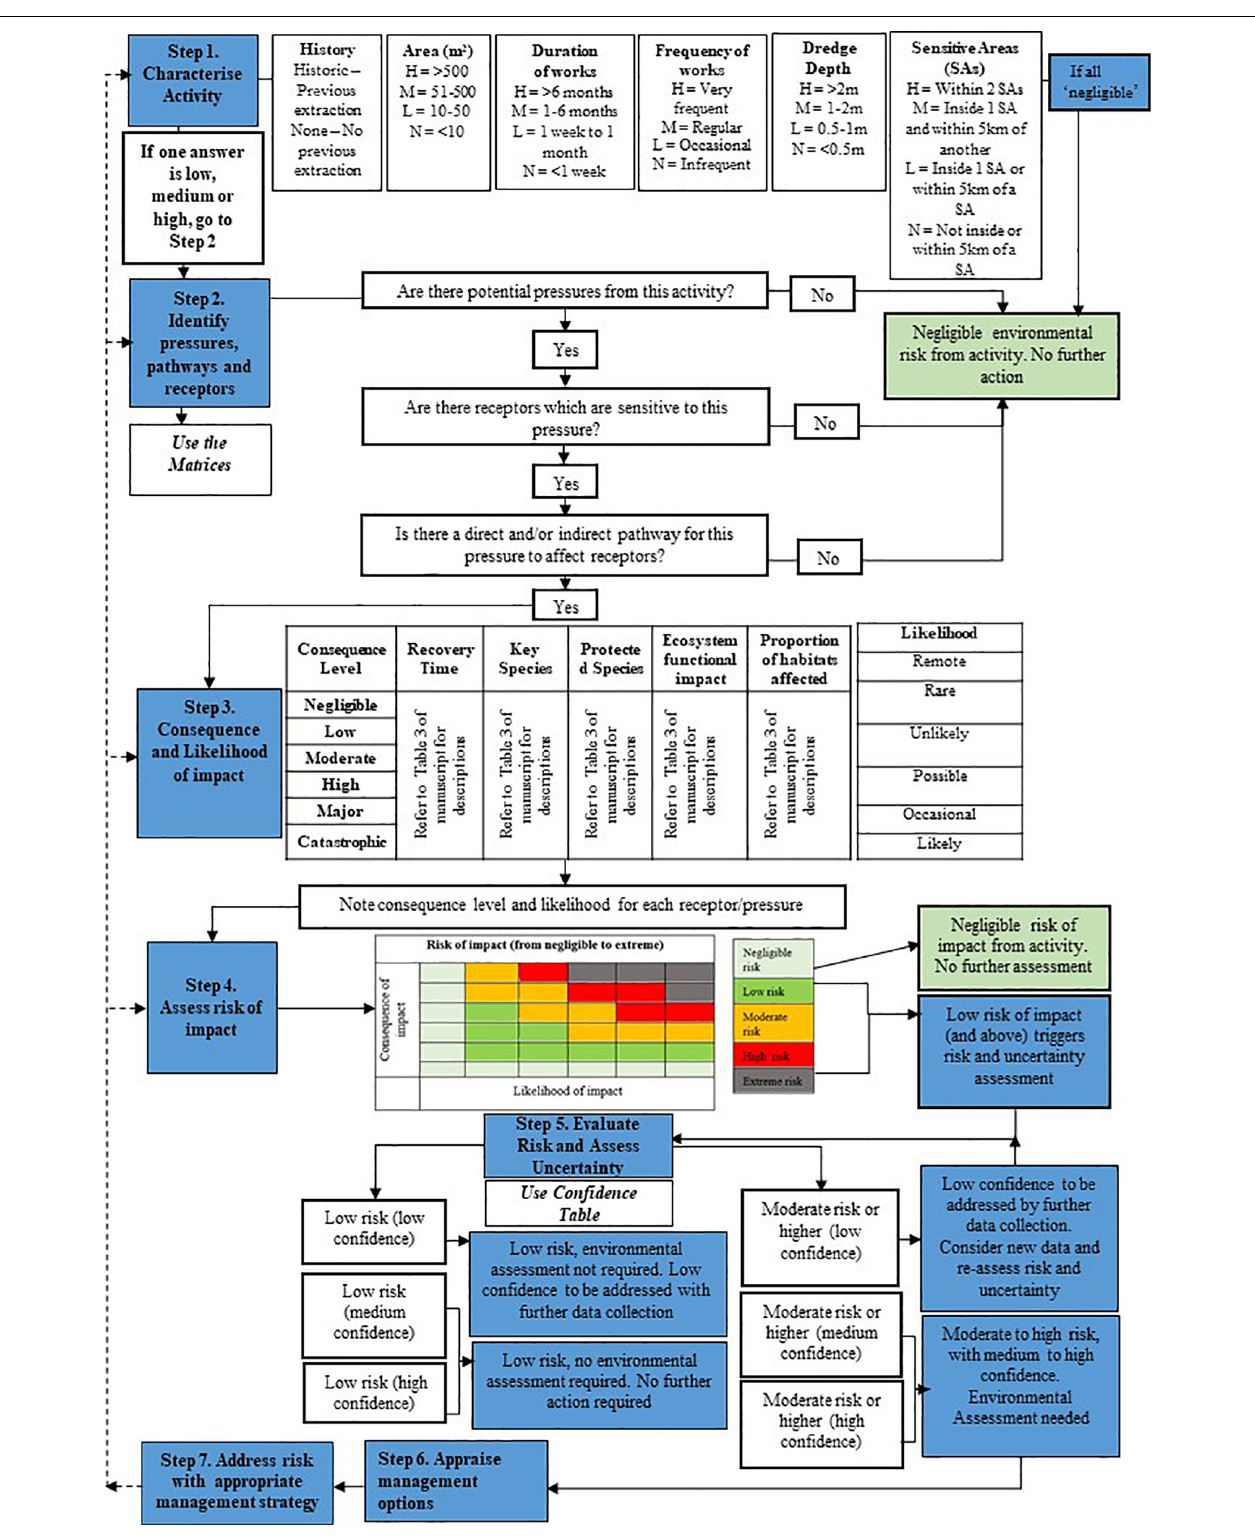
FIGURE 1 | Decision tree for assessing potential risks posed by sand extraction and actions required. ‘H’ High risk; ‘M’ medium risk; ‘L’ low risk; ‘N’ negligible risk. Dashed lines represent feedback loops following the collection and assessment of data.